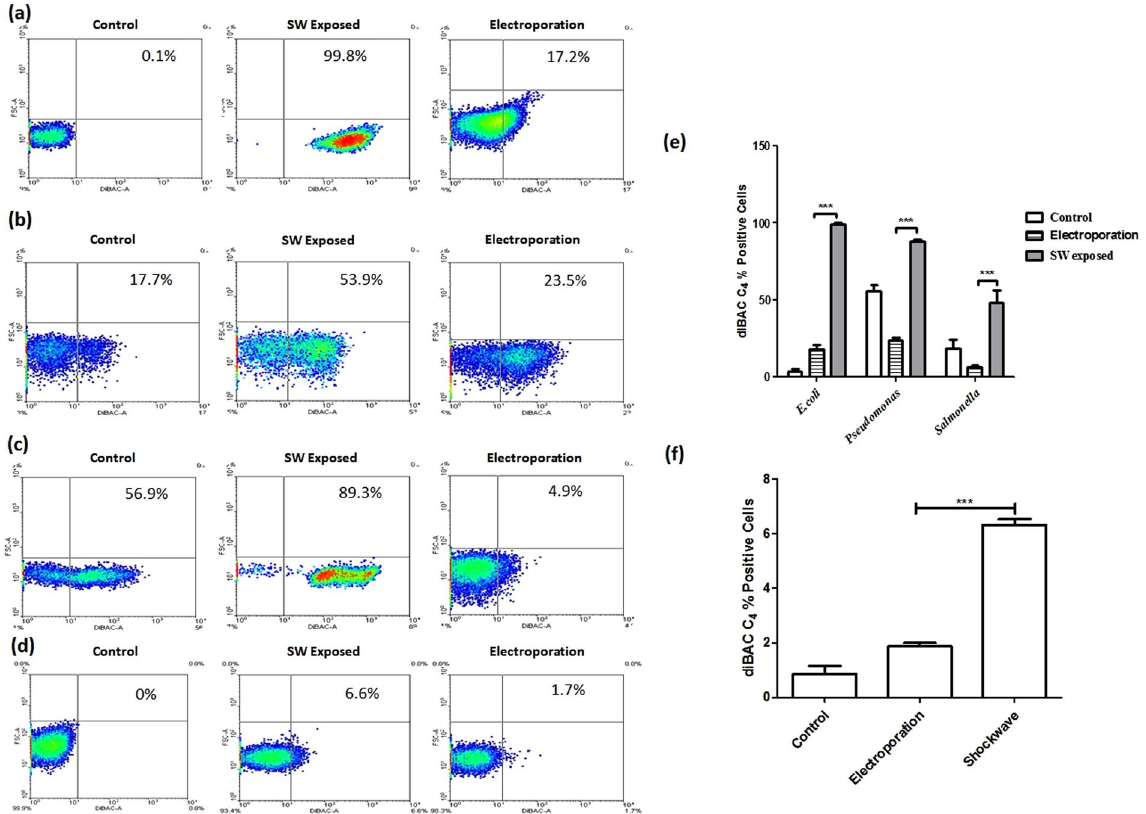
Figure 3. Effect of shockwaves on membrane depolarization. ( a–d ) diBACC4 assay was performed to assess the change in the membrane polarity during the exposure to shockwave in E.coli, Pseudomonas , Salmonella and Mycobacterium smegmatis . The bacteria were incubated with diBACC4 (1 µ g/ml) prior to shockwave exposure. The bacteria were analyzed using flow cytometry for change in the membrane polarity. Results are representative of three independent experiments with similar results. ( e–f ) Comparison of the percent diBACC4 positive cells in E.coli, Pseudomonas , Salmonella and Mycobacterium smegmatis . Statistical significance was defined as follows ( * P < 0.05, ** P < 0.005, *** P < 0.0005) (Student’s t